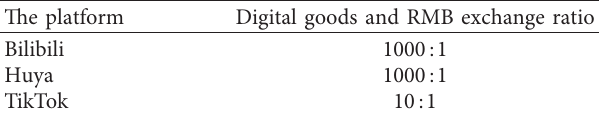
Table 3: The exchange ratio between virtual goods and RMB. The platform Digital goods and RMB exchange